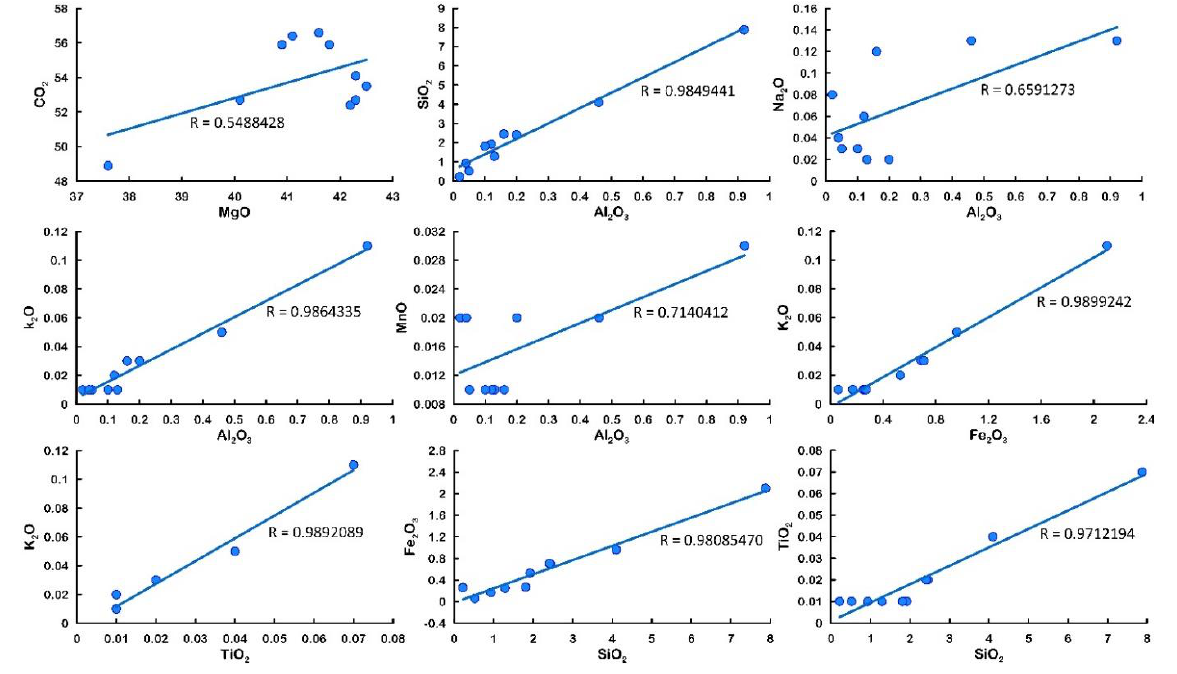
Figure 5. Positive correlation between some selected major oxides of stromatolites.